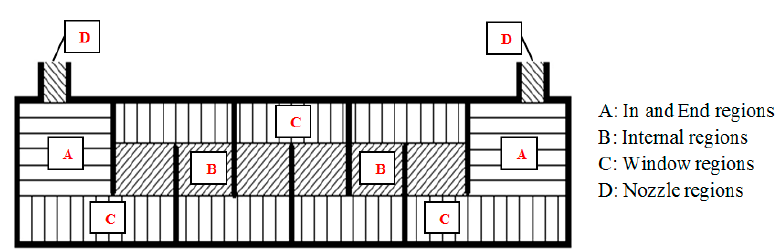
Figure 1. Pressure drop regions in a shell and tube heat exchanger.